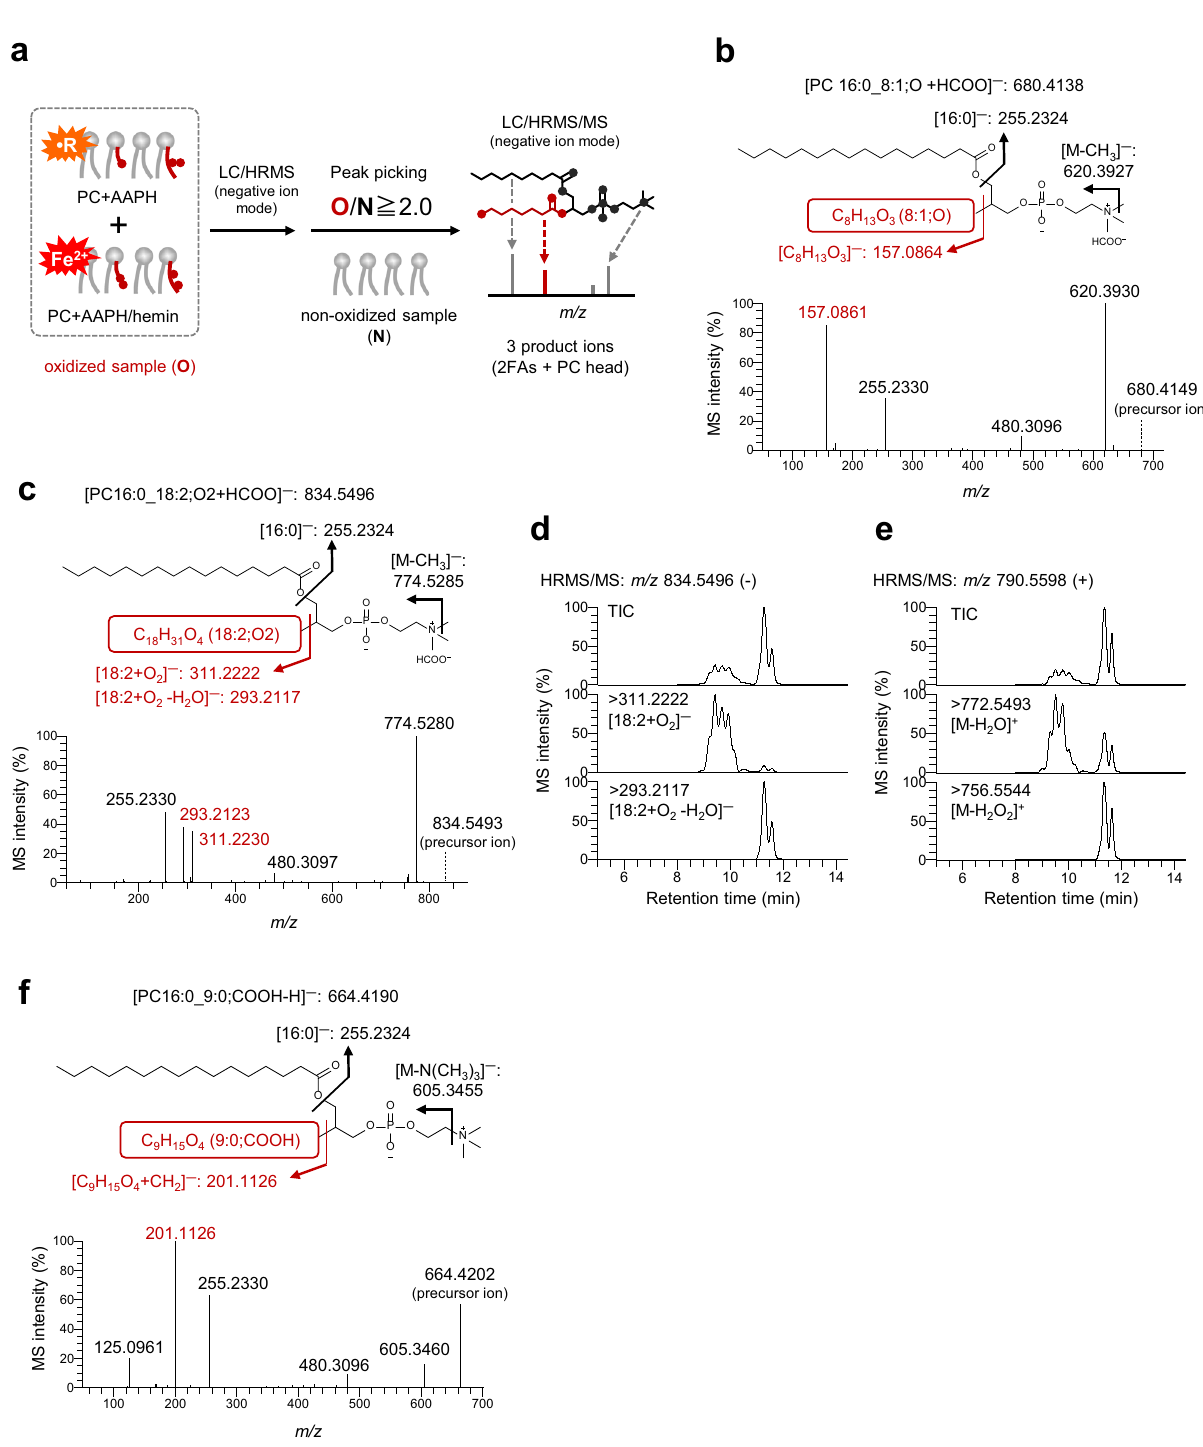
Fig. 1 Nontargeted analysis and annotation of oxidized PC16:0/PUFAs. a Outline of the LC/HRMS/MS-based nontargeted analysis of oxidized PCs generated by AAPH or AAPH + hemin stimulation. LC/HRMS/MS data were obtained by using data-dependent acquisition (DDA) in the negative ion mode. b HRMS/MS product ion spectrum of PC16:0_8:1;O ( m/z 680.4138, retention time ( t R ) = 6.6 min). The structure and proposed fragmentation of the ion with m/z 680.4138 are also shown. c Averaged HRMS/MS product ion spectrum of PC16:0_18:2;O2 ( m/z 834.5496, t R = 9.0 – 12.0 min). The structure and proposed fragmentation of the ion with m/z 834.5496 are also shown. d Extracted ion chromatograms (EICs) recorded in negative ion mode for the precursor ion at m/z 834.5496. Product ions at m/z 311.2222 and 293.2117 correspond to 18:2 + O 2 and 18:2 + O 2 − H 2 O, respectively. The total ion chromatogram (TIC) is shown. e EICs recorded in positive ion mode for the precursor ion at m/z 790.5598. Product ions at m/z 772.5493 and 756.5544 correspond to the loss of H 2 O and H 2 O 2 , respectively. f HRMS/MS product ion spectrum of PC16:0_9:0;COOH ( m/z 664.4190, t R = 3.0 min). The structure and proposed fragmentation of the ion with m/z 664.4190 are also